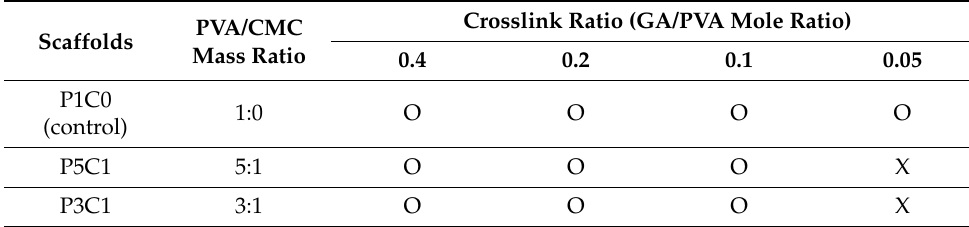
Table 1. Preparation of PVA/CMC scaffolds with different glutaraldehyde crosslinking. PVA and CMC were mixed and crosslinked by GA. P1C0 (PVA/CMC = 1:0) served as control group by the addition of water instead of